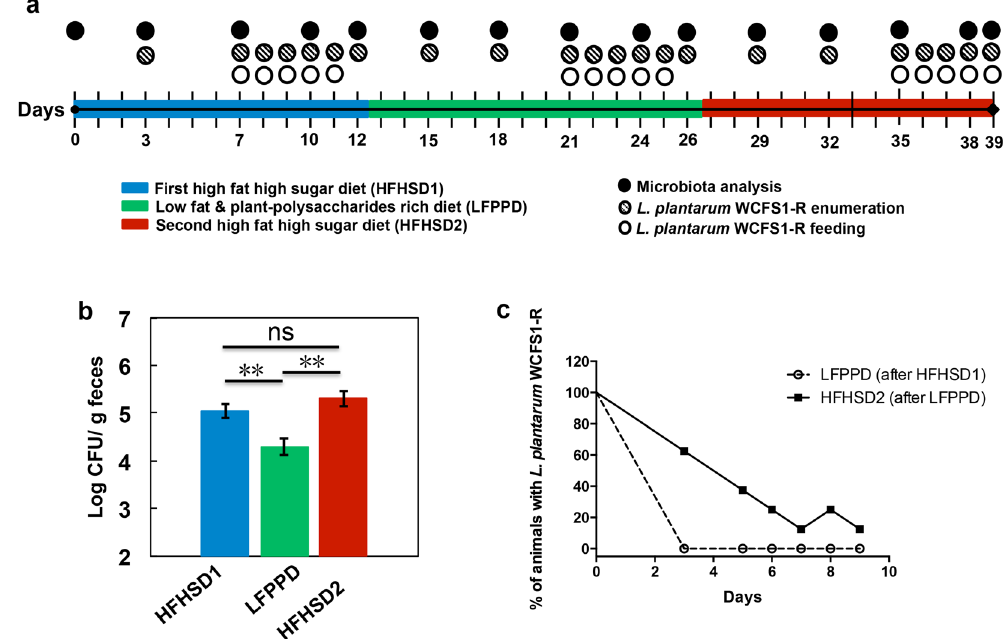
Figure 1. L . plantarum survived in higher numbers and persisted for longer periods in mice on HFHSD. ( a ) Experimental design of the mouse study. Mice starting on day 0 were switched from standard rodent chow to a HFHSD for 12 days (HFHSD1, blue), to a LFPPD for 14 days (green), and then back again to the HFHSD for a final 12 days (HFHSD2, red). L . plantarum WCFS1-R was fed orally during the last five consecutive days for each diet period (open circles). Mouse stools were collected at time points indicated in the figure for either L . plantarum enumeration (hatched circles) or 16S rRNA gene sequencing and qPCR (filled circles). ( b ) Culturable L . plantarum WCFS1-R in mouse stools 24 h after feeding as determined by colony enumeration. Rifampicin-resistant colonies were not detected in fecal samples collected from PBS-fed mice. The lower limit of detection was log 10 3.5 CFU/g stool. Data of total 8 mice for 5 consecutive days is shown. ** P < 0.01, Mann- Whitney U test. ( c ) L . plantarum WCFS1-R persistence in the mouse feces after the HFHSD1 period (during LFPPD consumption) and after the LFPPD period (during HFHSD2 consumption), as determined by CFU